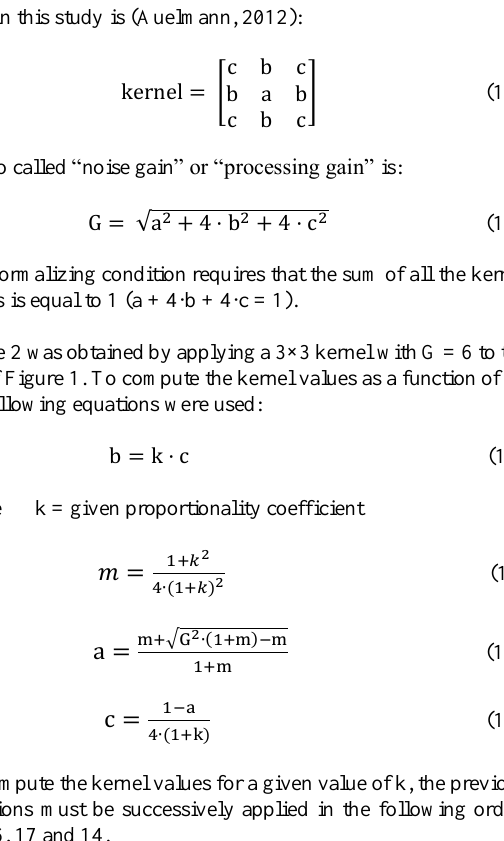
Table 3. GIQE 5 coefficients for GSD in metric